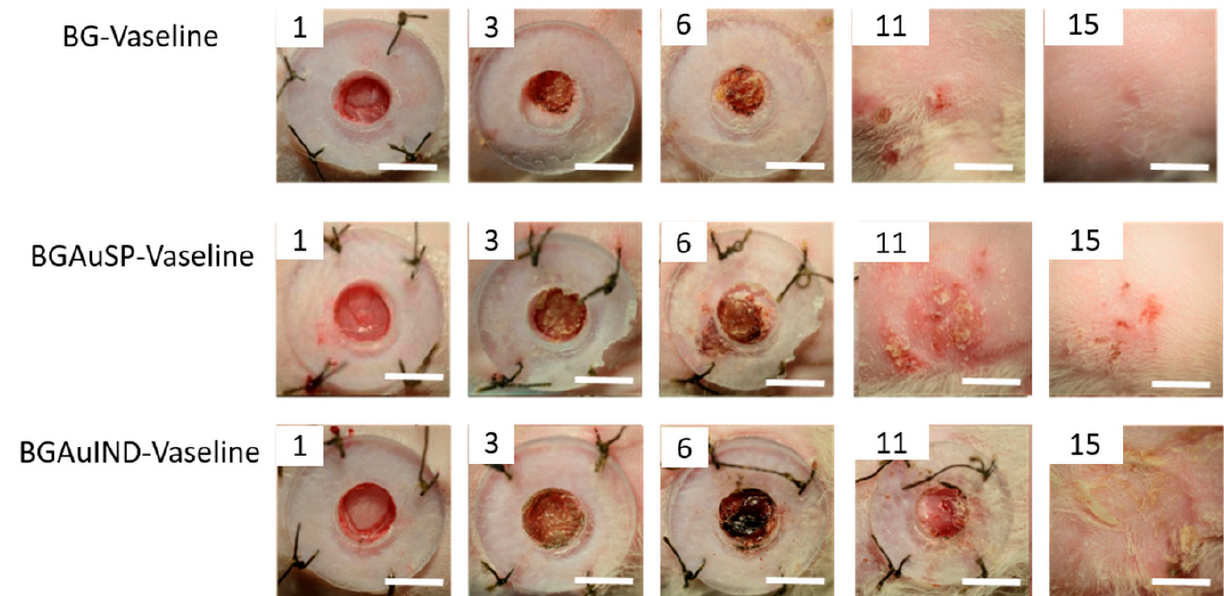
Figure 6. Representative images of full-thickness skin defect in rats with BG-Vaseline, BGAuSP-Vaseline and BG-AuIND- Vaseline ointments at 1, 3, 6, 11 and 15 days post-surgery. (Scale bar 6 mm).